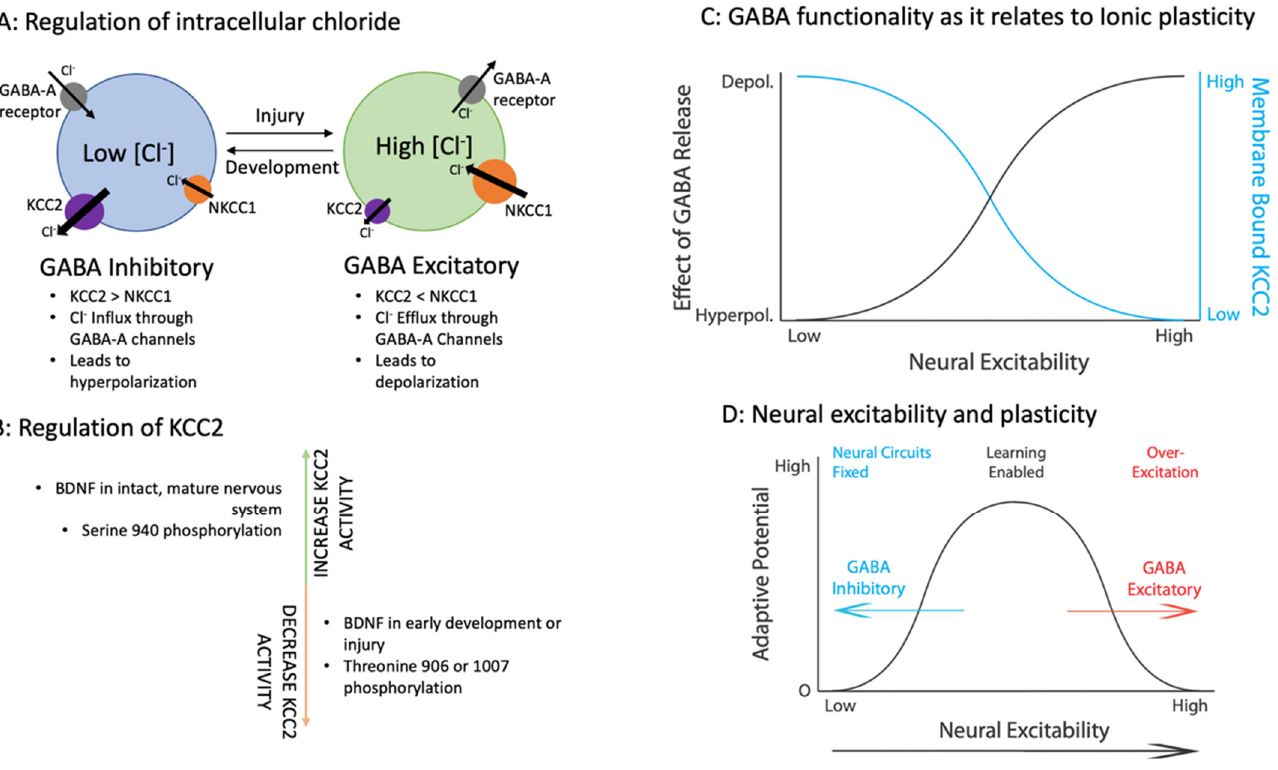
Figure 3. Overview of ionic plasticity. ( A ) Regulation of intracellular Cl − . Figure depicting the relative functional levels of KCC2: NKCC1, the direction of Cl − flux through GABA-A channels, and resultant effects of GABA activity on the cell. ( B ) Regulation of KCC2. Demonstrating the major effectors that increase and decrease KCC2 functionality. ( C ) GABA functionality as it relates to ionic plasticity. Demonstrating the inverse relation between KCC2 activity and GABA functionality. Adapted from: [19]. ( D ) Neural excitability and plasticity. Theorized relationship between the state of ionic plasticity and the state of neural plasticity. Adapted from: [19].